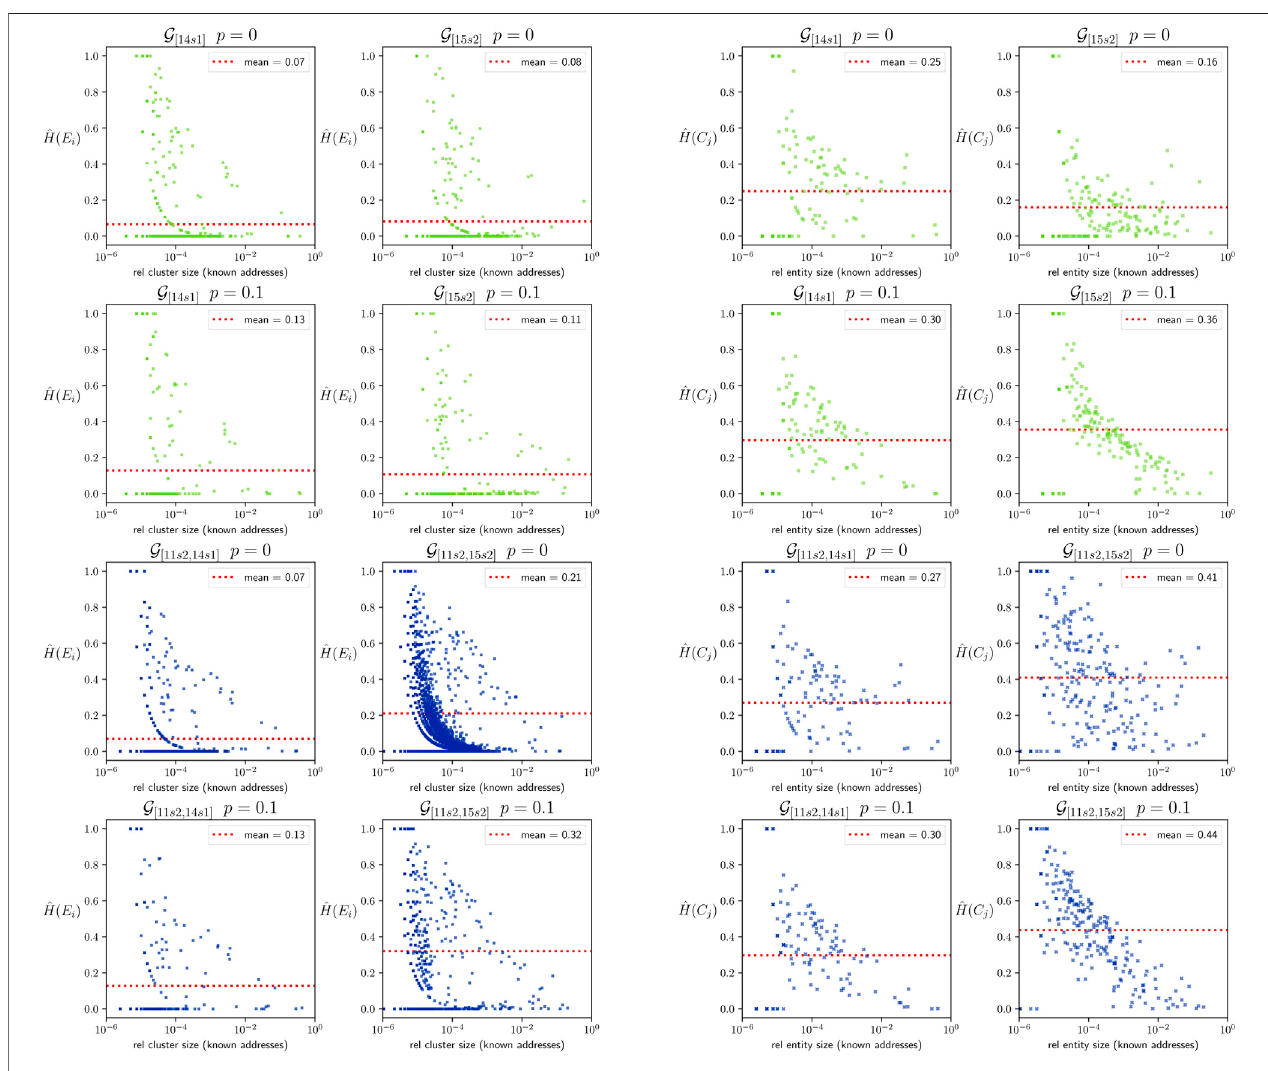
FIGURE 13 | Normalized entropy as a function of relative cluster size and relative entity